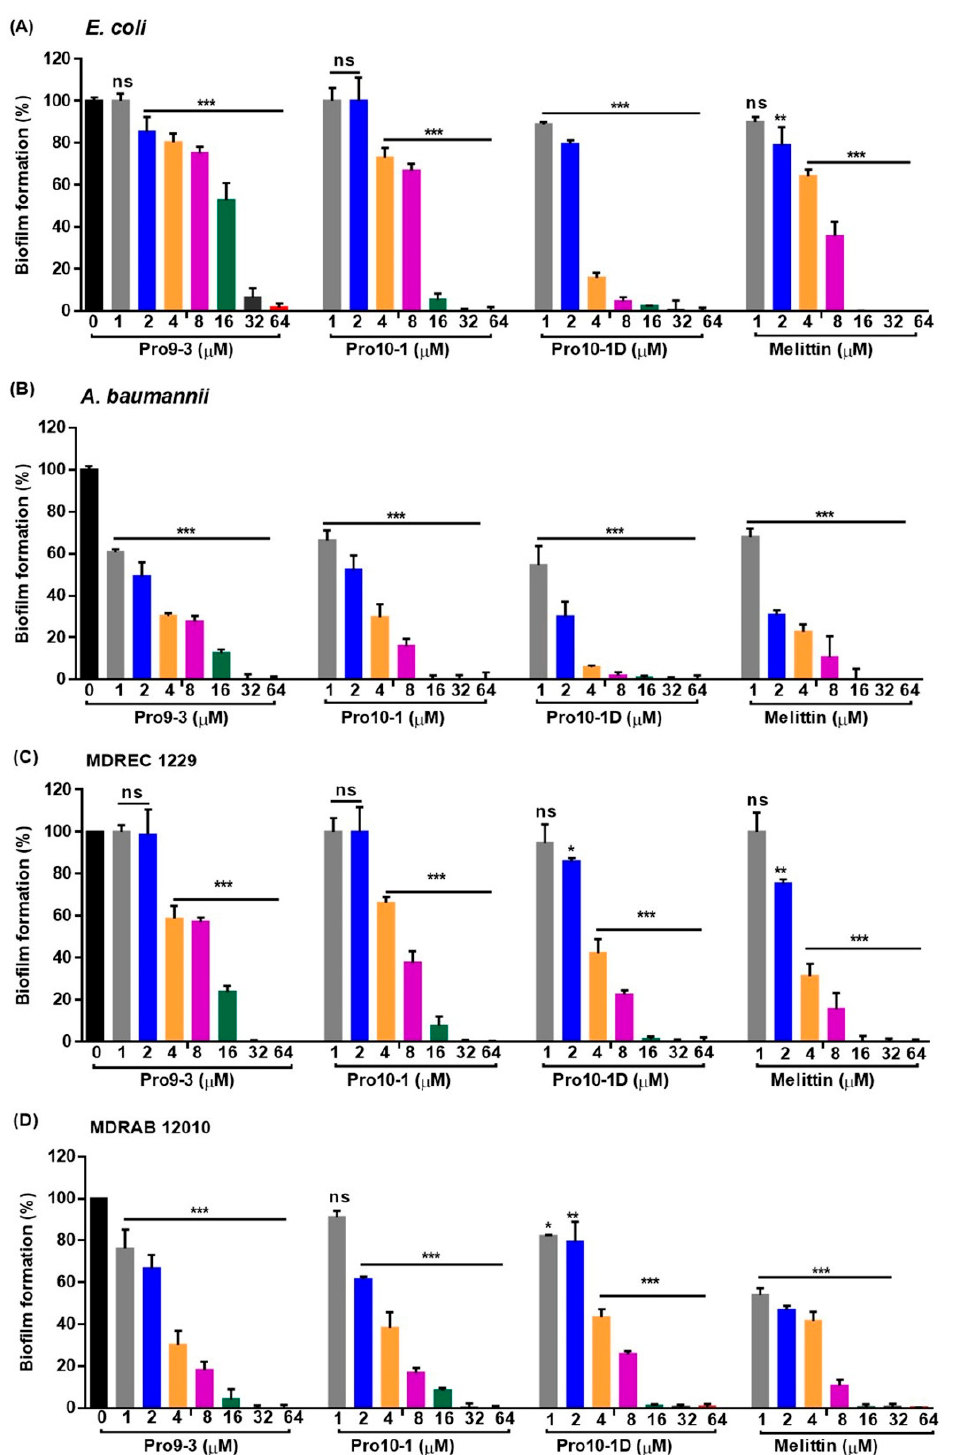
Figure 7. Inhibitory effects of Pro9-3, Pro10-1, and Pro10-1D on bacterial biofilm formation: Biofilm degradation properties of peptides were measured against ( A ) E. coli , ( B ) A. baumannii , ( C ) MDREC 1229, and ( D ) MDRAB 12010 in a dose-dependent manner. Melittin was used as a control. Data are shown as the mean ± SEM ( n = 3) and are statistically significant at * p < 0.05, ** p < 0.01, and *** p < 0.001; ns, not significant by one-way ANOVA , Tukey’s post hoc test .